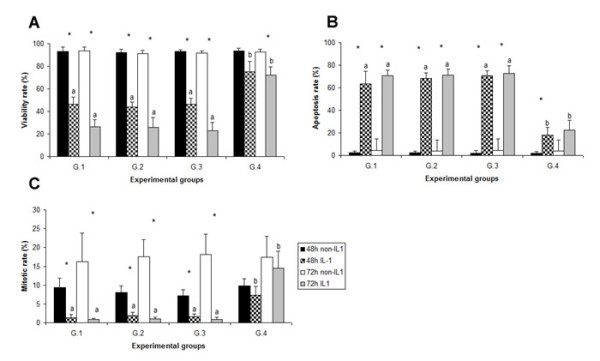
Viability (A), apoptosis (B) and mitotic (C) rate in all experimental groups. Individual bars show the mean ± SD. A significant difference (p < 0.05) between the four groups at the same condition (48 h non-IL1, 48 h IL1, 72 h non-IL1 and 72 h IL1) is displayed with superscript (a, b) on the bars. A significant difference (p < 0.05) between treatment and non-treatment with IL-1β at the same period (48 or 72 h) is displayed with superscript (*) on the bars. G1 = control group; G.2 = solution control; G.3 = non-silencing siRNA; and G.4 = MMP-3 siRNA.